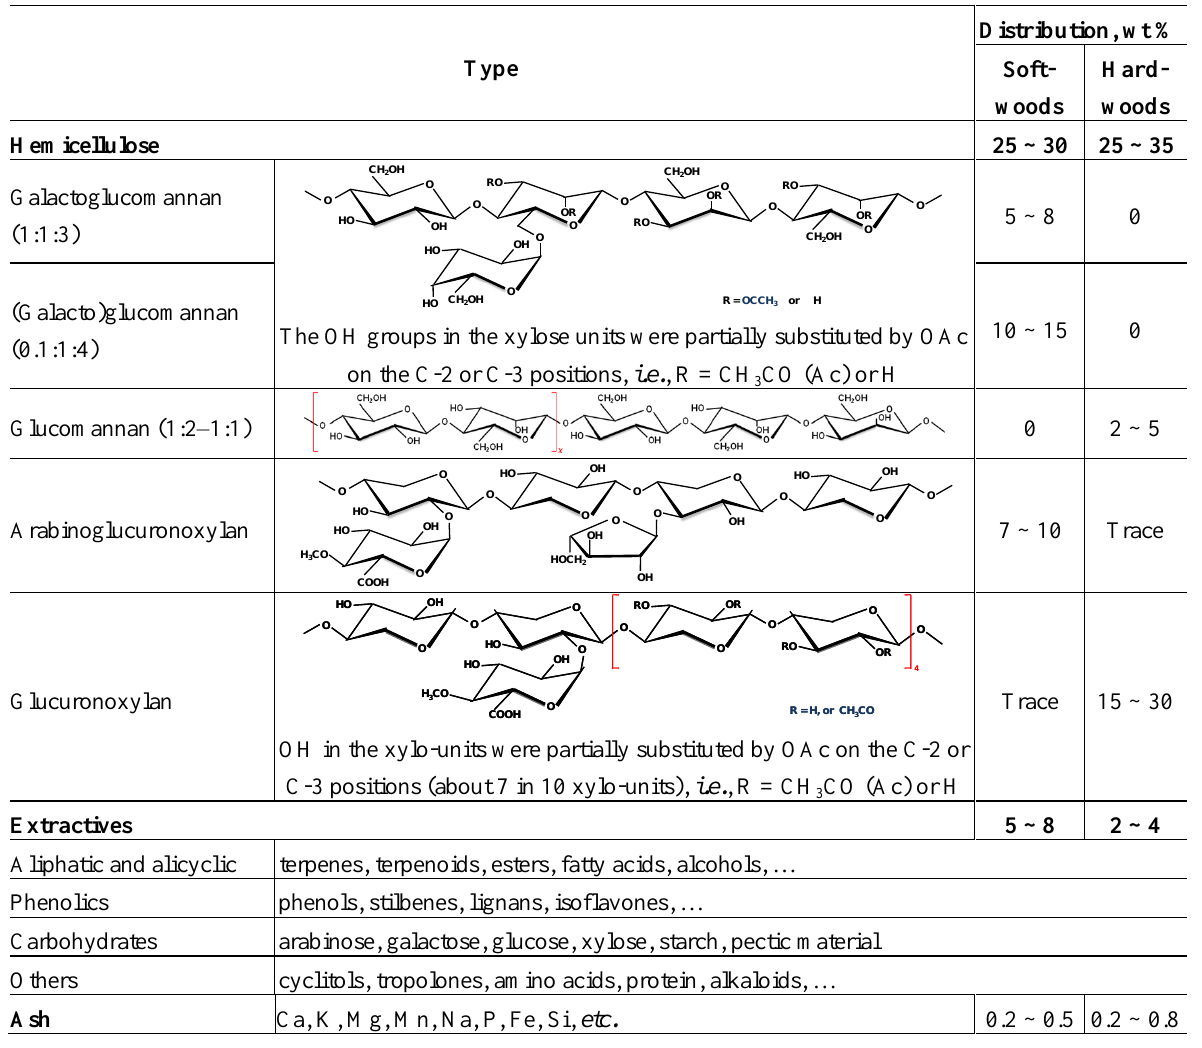
Table 1. Important components of hemicelluloses and extractives [21].